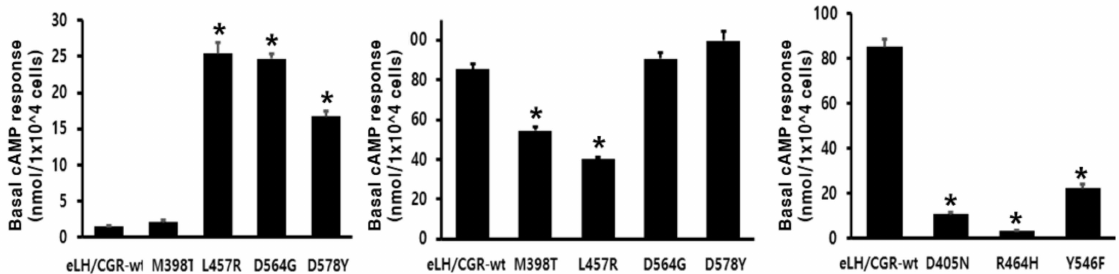
Figure 5. The results of basal cAMP responsiveness in activating mutants and Rmax level in activating/inactivating mutants. The basal and maximal AMP responses presented in Figures 3 and 4 are displayed using a bar graph. * Statistically significant differences ( p < 0.05) when compared with the wild-type receptor. A representative data set performed in triplicate out of two independent experiments. * Statistically significant differences in basal cAMP response and Rmax cAMP response ( p < 0.05) compared to the expression of the wild-type